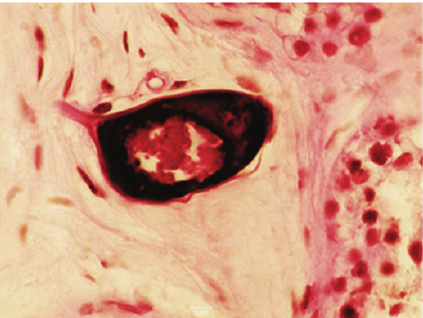
Figure 1: Histologic sections of the surgical specimen showed egg of S. mansoni with the characteristic lateral spine.